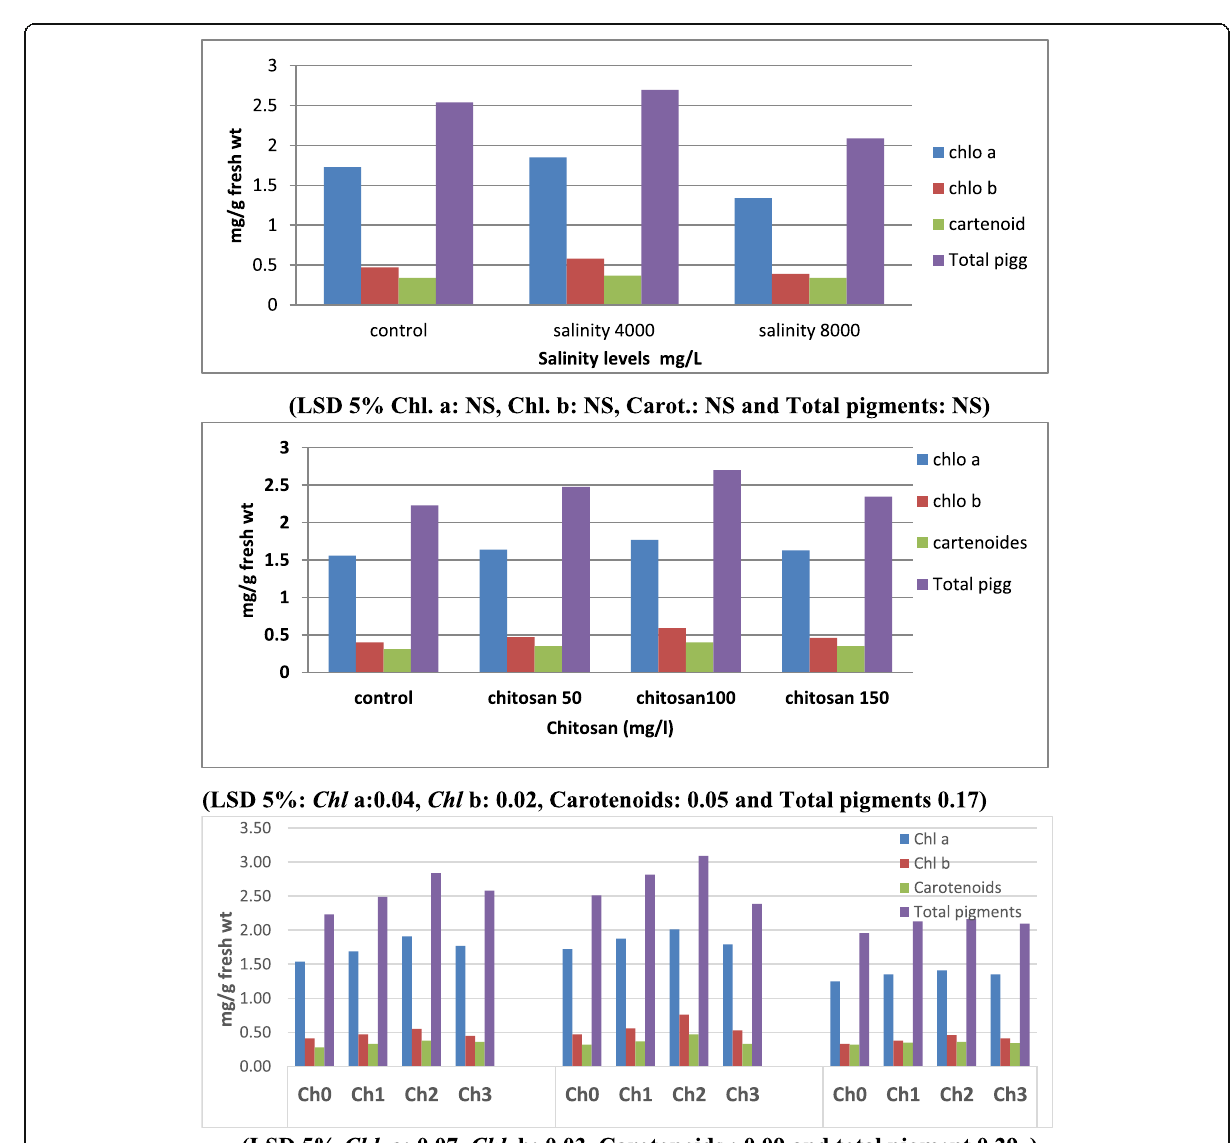
Fig. 1 Effect of salt stress mg/L (S0, S1, and S2), chitosan concentration (Ch0, Ch1, Ch2, and Ch3), and their interaction on photosynthetic pigments (mg/g fresh wt) of sunflower